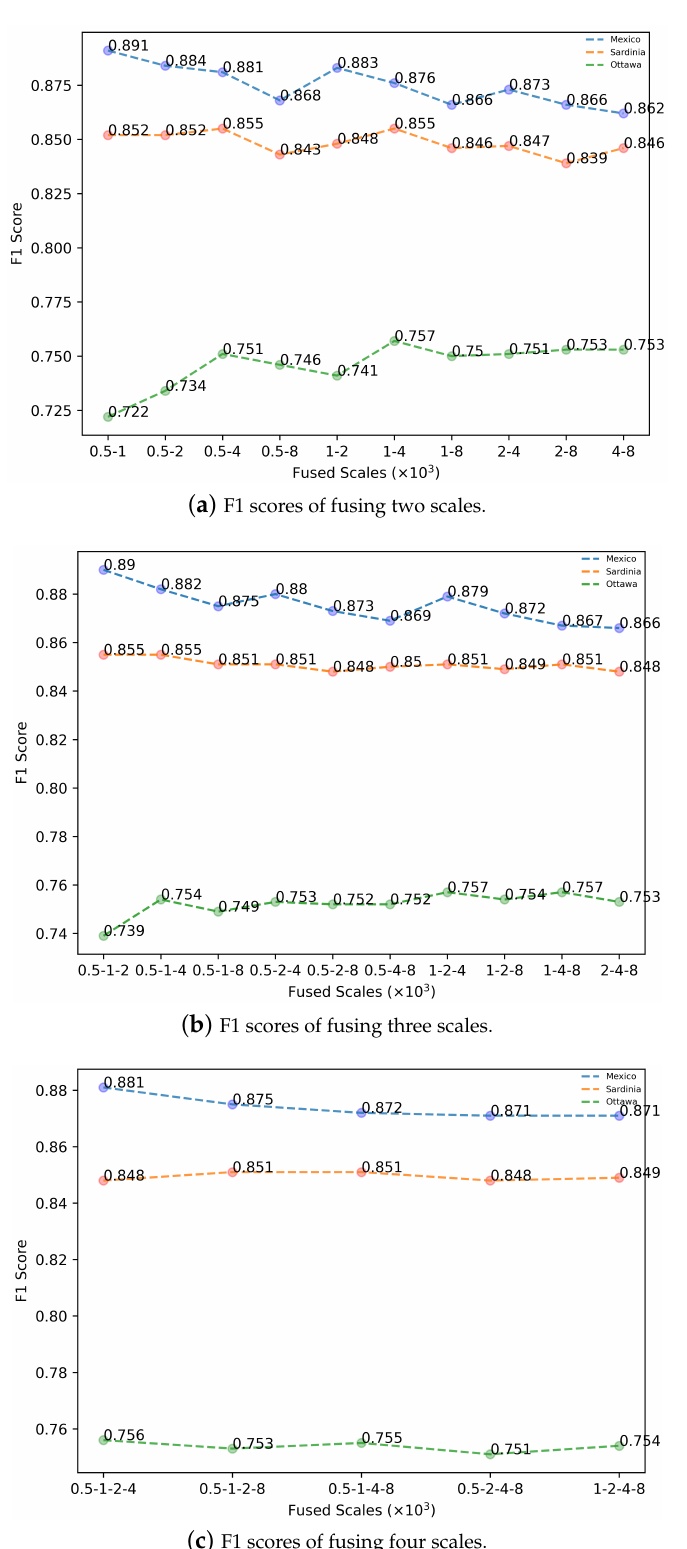
( c ) F1 scores of fusing four scales. Figure 7. F1 scores of different fusion cases for the three experimental datasets. ( a ): F1 scores of fusing two scales. ( b ): F1 scores of fusing three scales. ( c ): F1 scores of fusing four